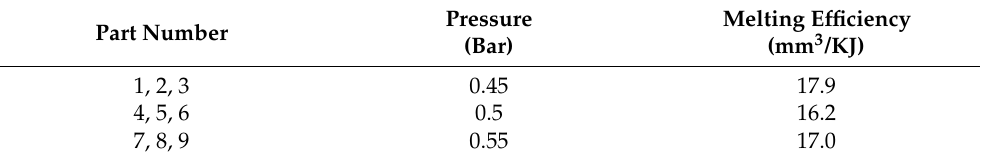
Table 4. Average melting efficiency